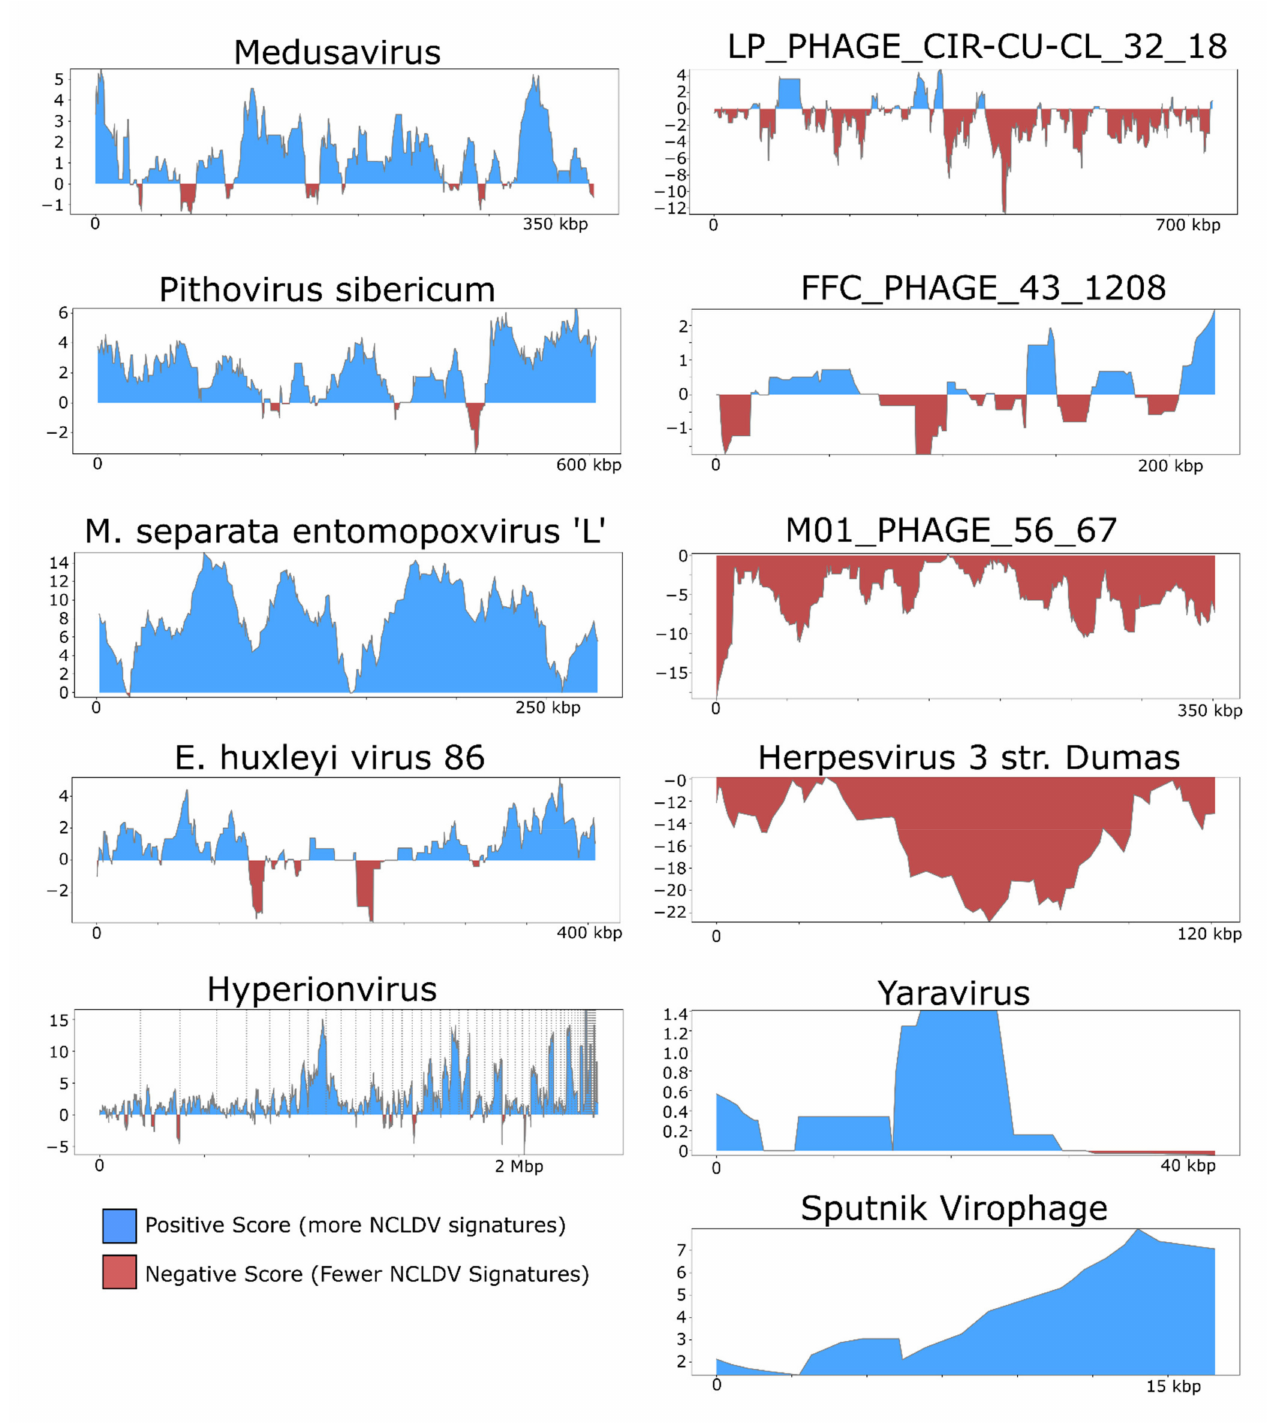
Figure 3. ViralRecall plots of diverse dsDNA viruses. NCLDV genomes are shown on the left, while the right pan- els show other dsDNA viruses, or highly divergent NCLDV in the case of Yaravirus. The jumbo bacteriophages LP_PHAGE_COMPLETE_CIR-CU-CL_32_18, FFC_PHAGE_43_1208, and M01_PHAGE_56_67 were chosen because they have the longest length, highest score, and lowest score, respectively, among the 336 jumbo phages